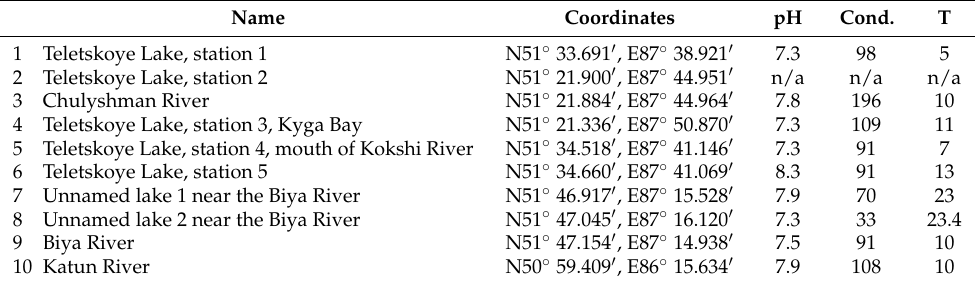
Table 1. Basic characteristics of the localities (Cond.—specific conductance, µ S cm − 1 , T—temperature, ◦